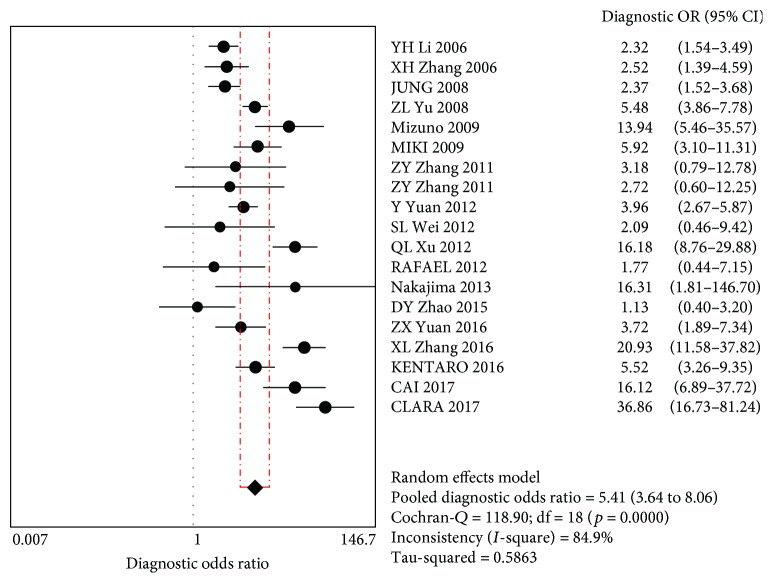
Diagnostic ratios.